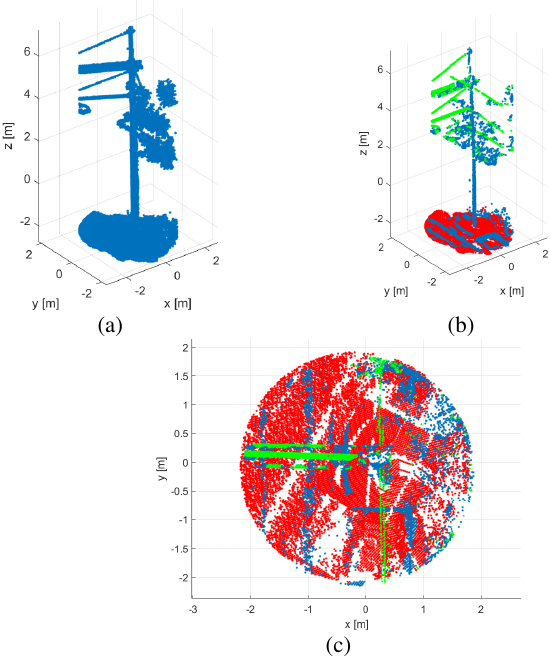
Figure 7. Example of point cloud pre-processing (vegetation elimination): (a) original data, (b) segmentation side view, mast (blue), cantilever and wires (green), ground (red), (c) segmentation re-oriented top